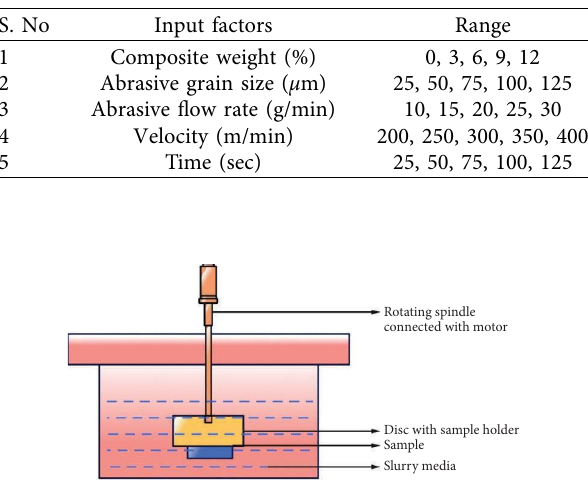
Table 2: Abrasive wear’s input factors.